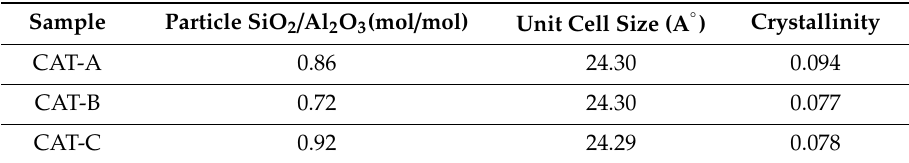
Table 1. Properties of the studied catalysts.